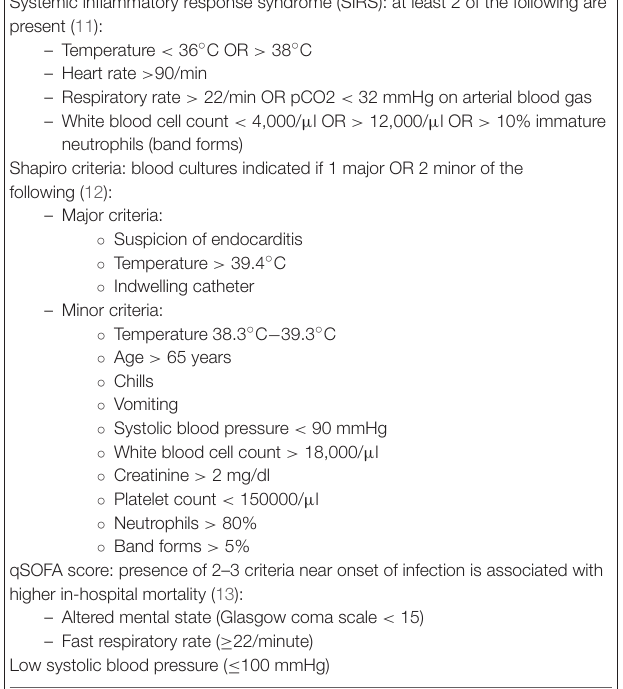
FIGURE 2 | Models and scores to predict BSI: SIRS criteria, Shapiro criteria & qSOFA score ( 11–13).